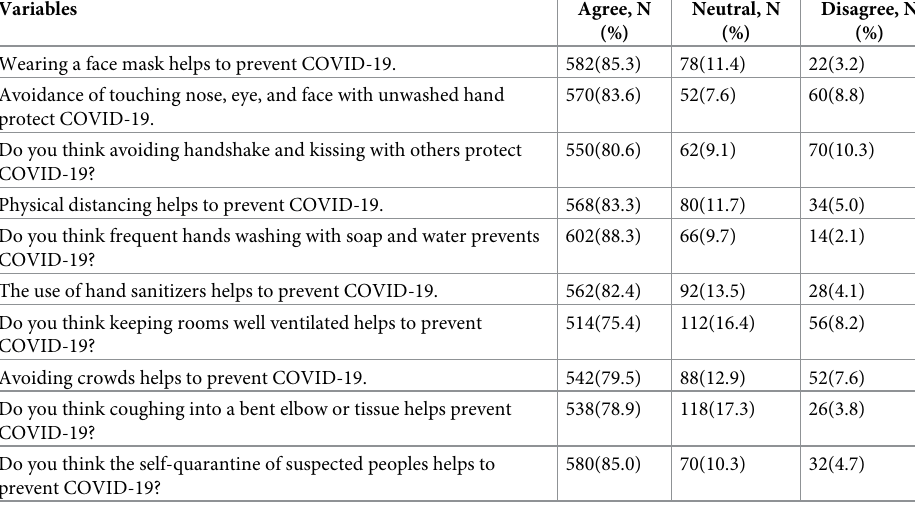
Table 3. Students’ attitude towards COVID-19 prevention measures in DBU, 2020.